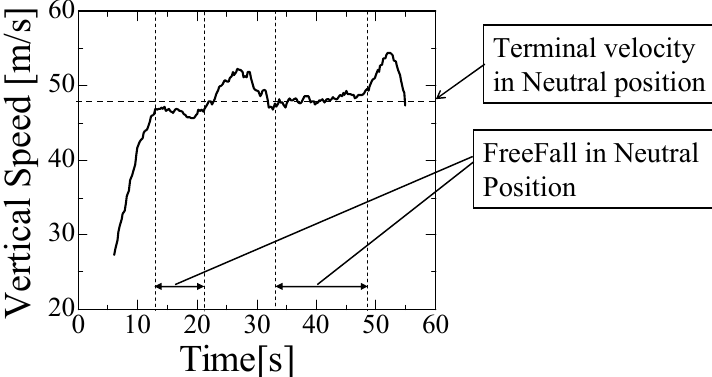
Experimental results of vertical